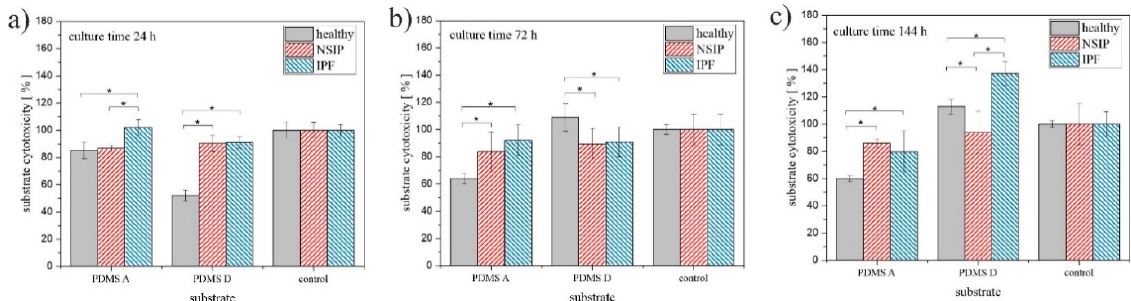
Figure 5. Substrate cytotoxicity determined for healthy (gray), NSIP- (red), and IPF-derived (blue) fibroblasts cultured for 24 h ( a ), 72 h ( b ), and 144 h ( c ). Statistical significance was achieved for p < 0.01 (*).